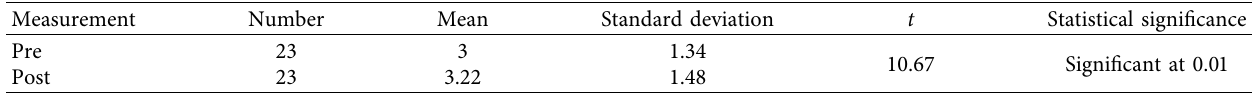
Table 5: The results of the t -test and the significance of the differences for the two measurements, pre and post, for the experimental group in the reading comprehension skills test at the direct comprehension level.